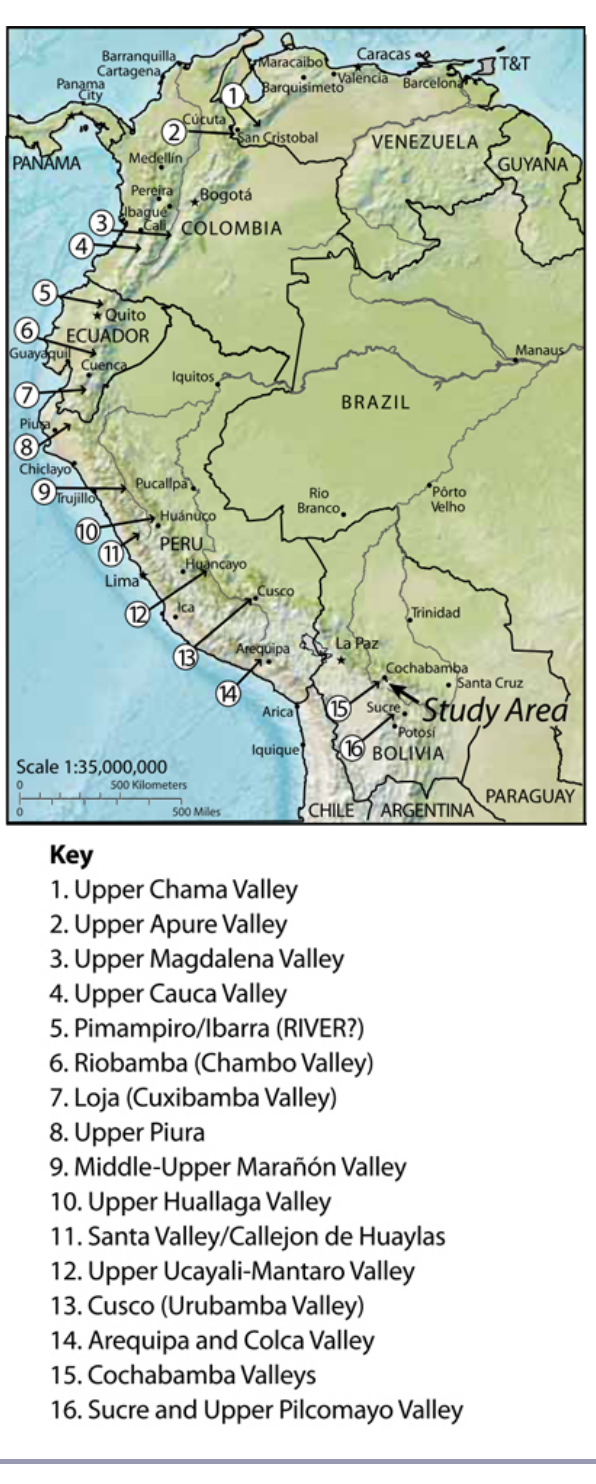
Fig. 2 . Examples of major cultural landscapes of the agrobiodiversity of Andean maize in western South America; enumerated examples show Andean valley and foothill